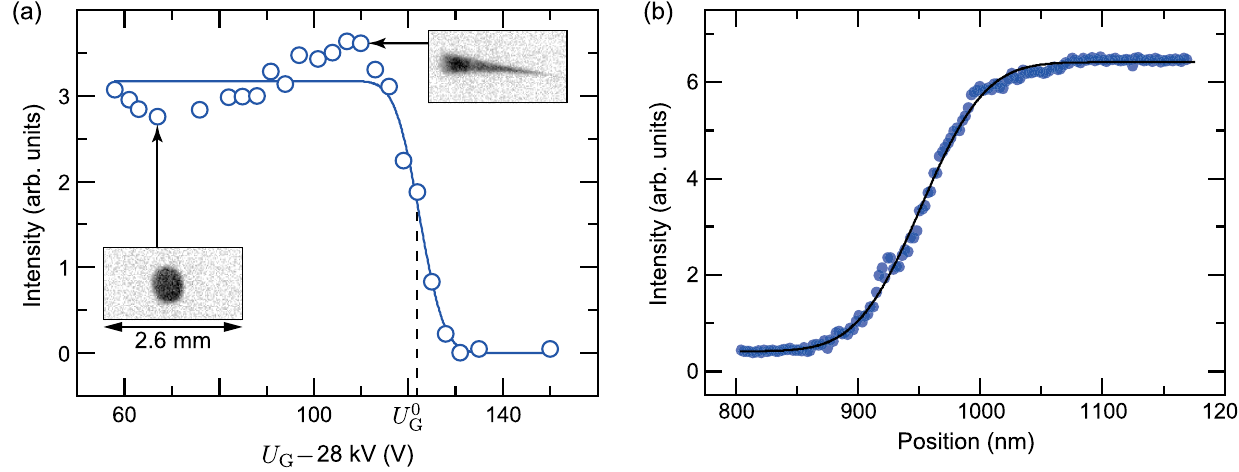
FIG. 6 (color online). (a) Integrated energy spectrum of the electron beam measured with the retarding field spectrometer shown in ¼ 28122 V implying that for Fig. 7. The fitted width of the cutoff edge is 9.7 eV (FWHM). The spectrometer center voltage is U 0 G U ¼ U 0 half of the dc electron beam current is blocked. The intensity in (a) and (b) has been obtained by integrating MCP images. The G G wavy behavior between 60 V and 110 V is due to defocusing of the electron beam with the retarding field analyzer (einzel lens). The integrated intensity appears smaller if the electron beam is more localized on the MCP. Corresponding MCP images (gray scale; white: no electrons) are shown as insets. (b) Typical measurement of the electron beam focal spot size measured by moving the edge of the ¼ 58 nm. Consecutive mesa structure into the beam ( “ knife-edge method ” ). The fit corresponds to a 1 =e focal waist radius of w e ¼ 50 nm and w ¼ 90 nm, from which we infer w ¼ ð 70 (cid:1) 20 Þ measurements scatter between w e e e